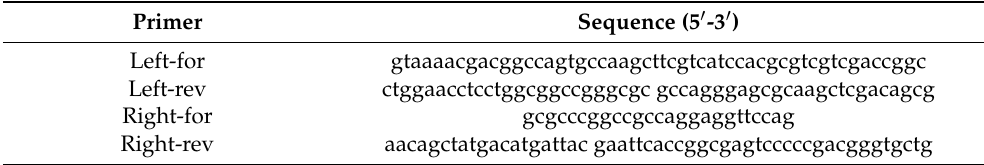
Table 1. Primers used in this study. Primer Sequence (5 (cid:48) -3 (cid:48) ) Left-for gtaaaacgacggccagtgccaagcttcgtcatccacgcgtcgtcgaccggc Left-rev ctggaacctcctggcggccgggcgc gccagggagcgcaagctcgacagcg Right-for gcgcccggccgccaggaggttccag Right-rev aacagctatgacatgattac